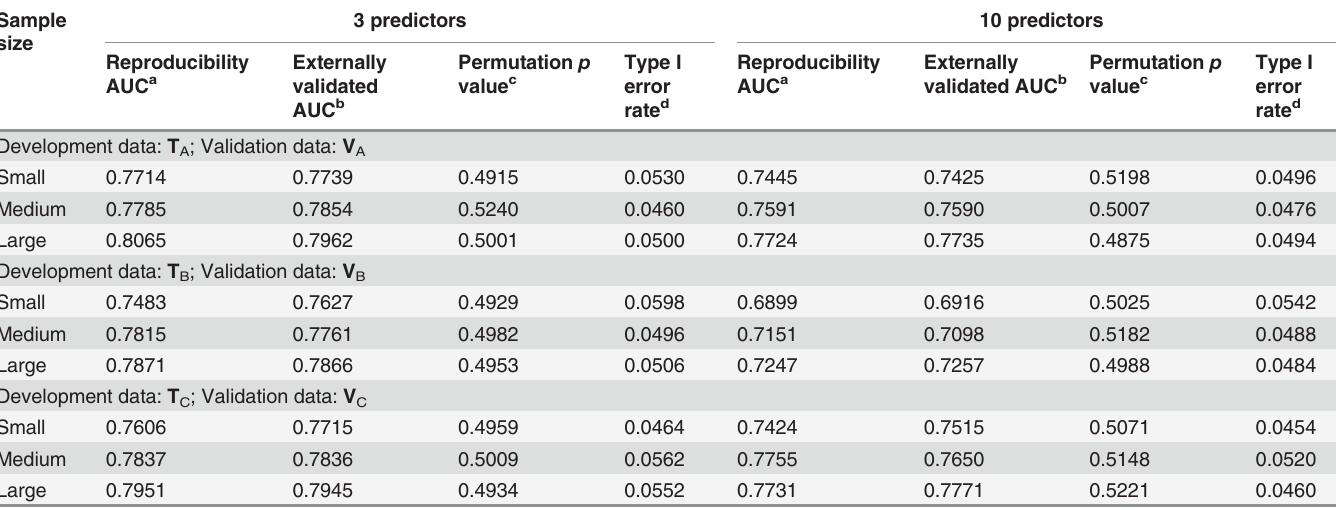
Table 1. Results of the permutation analysis for the homogeneity scenarios. Sample